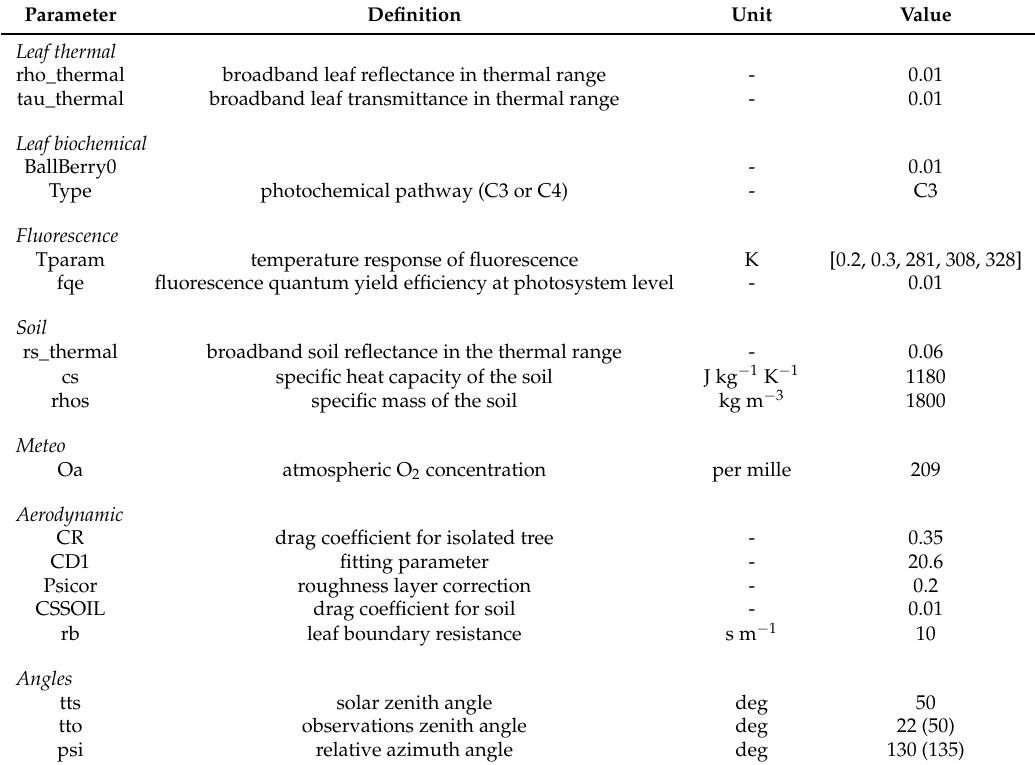
Table A3. Input parameters of the SCOPE model that were fixed during the global sensitivity analysis. Angles in brackets are related to the oblique view. Varied SCOPE parameters are listed in Table